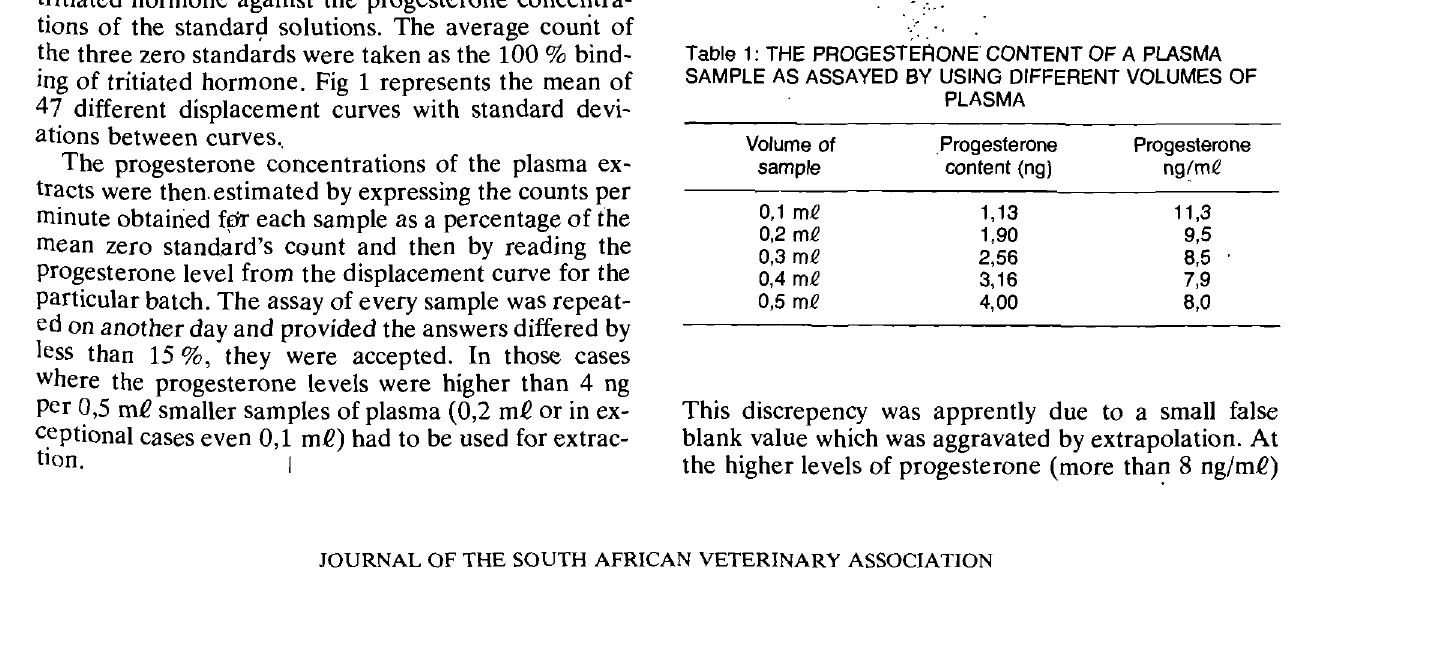
Fig. 1. The mean standard displacement curve. (Vertical bars rep resent the standard deviations between 4~ curves).